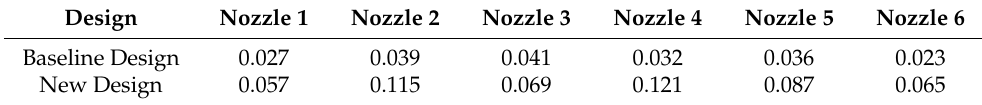
Table 5. Comparison of the swirl numbers for the distributor.